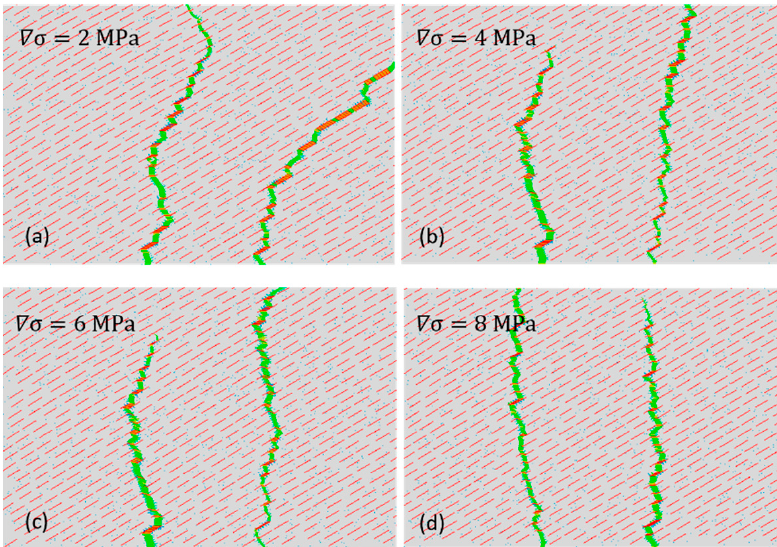
Figure 8. Effect of stress difference on hydraulic fracture propagation. ( a ) Stress difference = 2 MPa; ( b ) stress difference = 4 MPa; ( c ) stress difference = 6 MPa; ( d ) stress difference = 8 MPa.